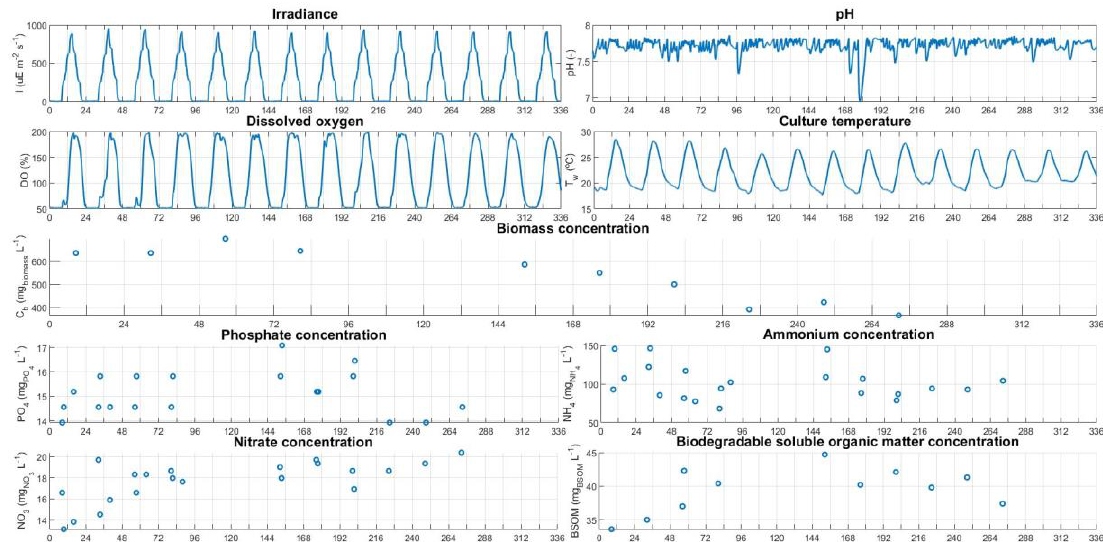
Figure 4. Input variables for calibration.